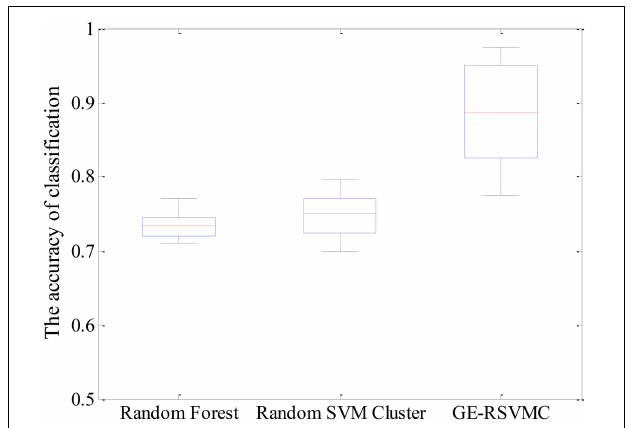
FIGURE 4 | Accuracies of various models.